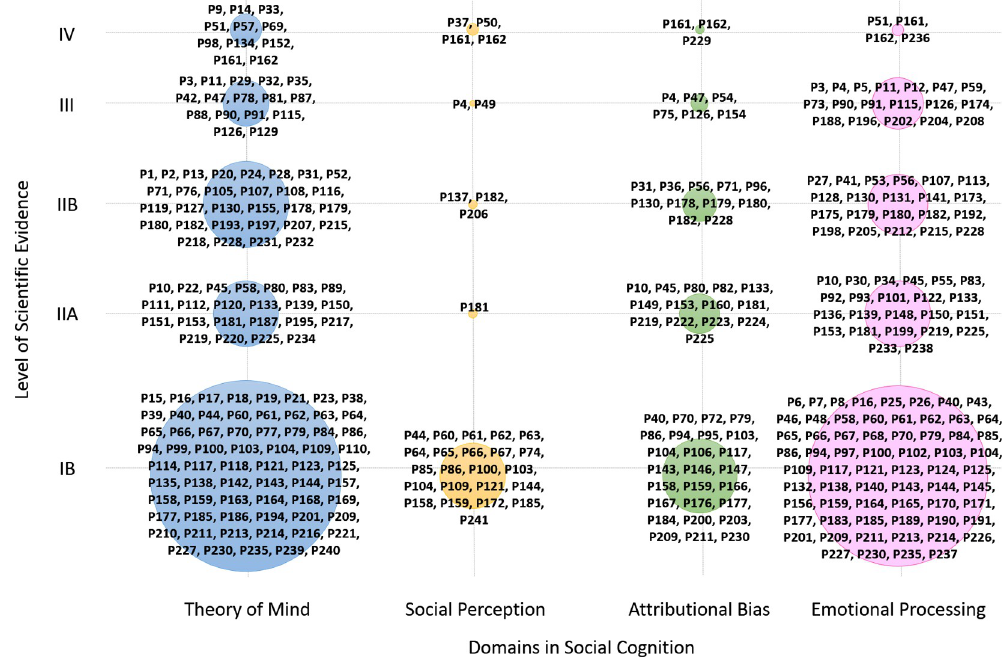
Fig 4. Categorization of papers in terms of social cognition domain and level of scientific